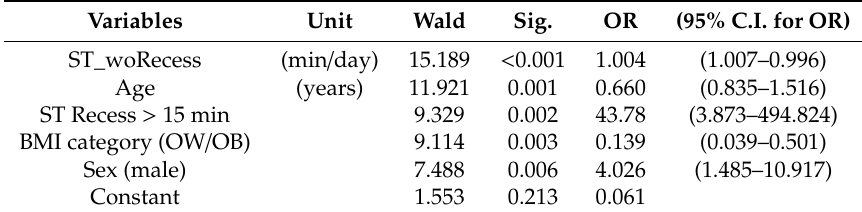
Table 4. Binary logistic regression for healthy / unhealthy VO 2Peak